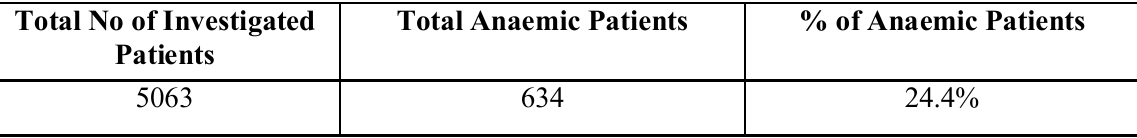
Table 1: Incidence of anemia in both 2-6 and 7-12 years children